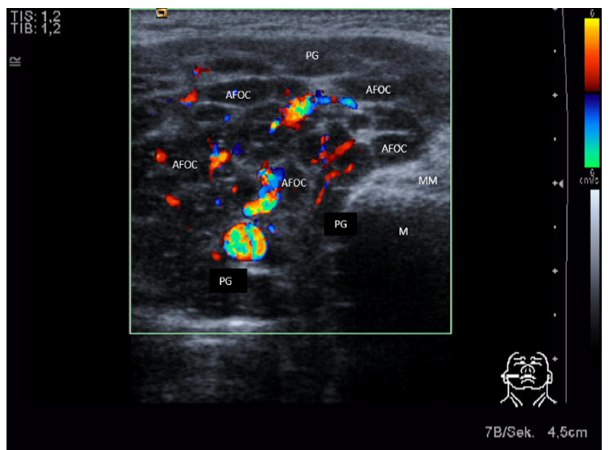
Figure 14. Acute stage of M. Sjögren in a right-sided PG. The gland is massively enlarged. Hypoechoic areas (active foci) are visible throughout the parenchyma and represent a massive infiltration of lymphatic cells The echotexture appears honeycomb-like. Perfusion is massively increased. Regular gland tissue is nearly not visible any more. Abbreviations: PG, parotid gland; M, mandible; MM, masseter muscle; AFOC, active focus.